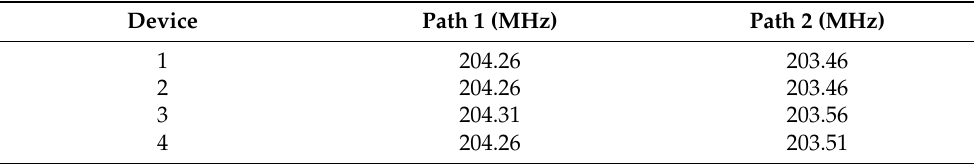
Figure 7. Conformance testing of SAW devices (The red line is the return loss, and the blue line is the transmission loss.). Table 1. Sensor conformance test center frequency